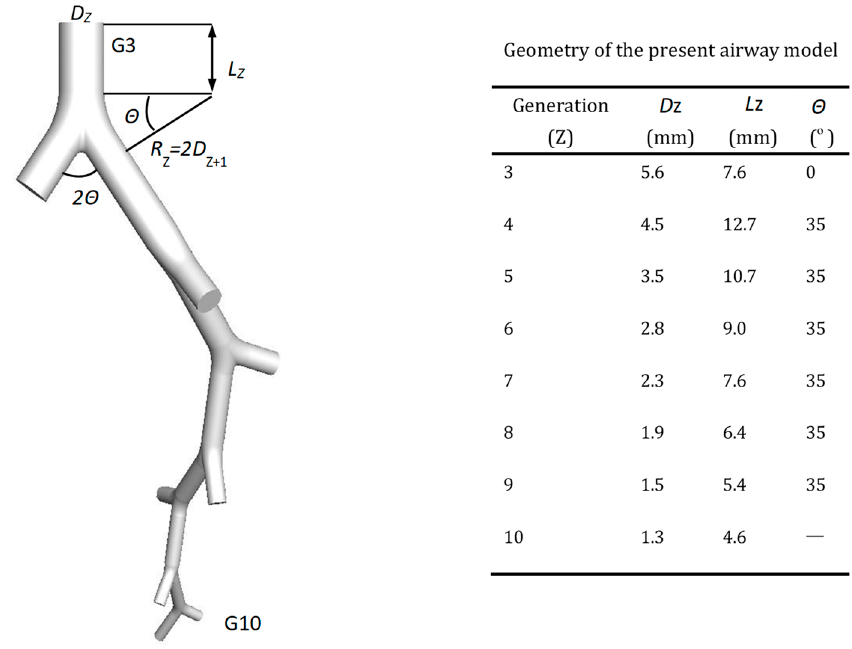
Figure 1. Truncated eight-generation model based on Weibel lung morphology [32].